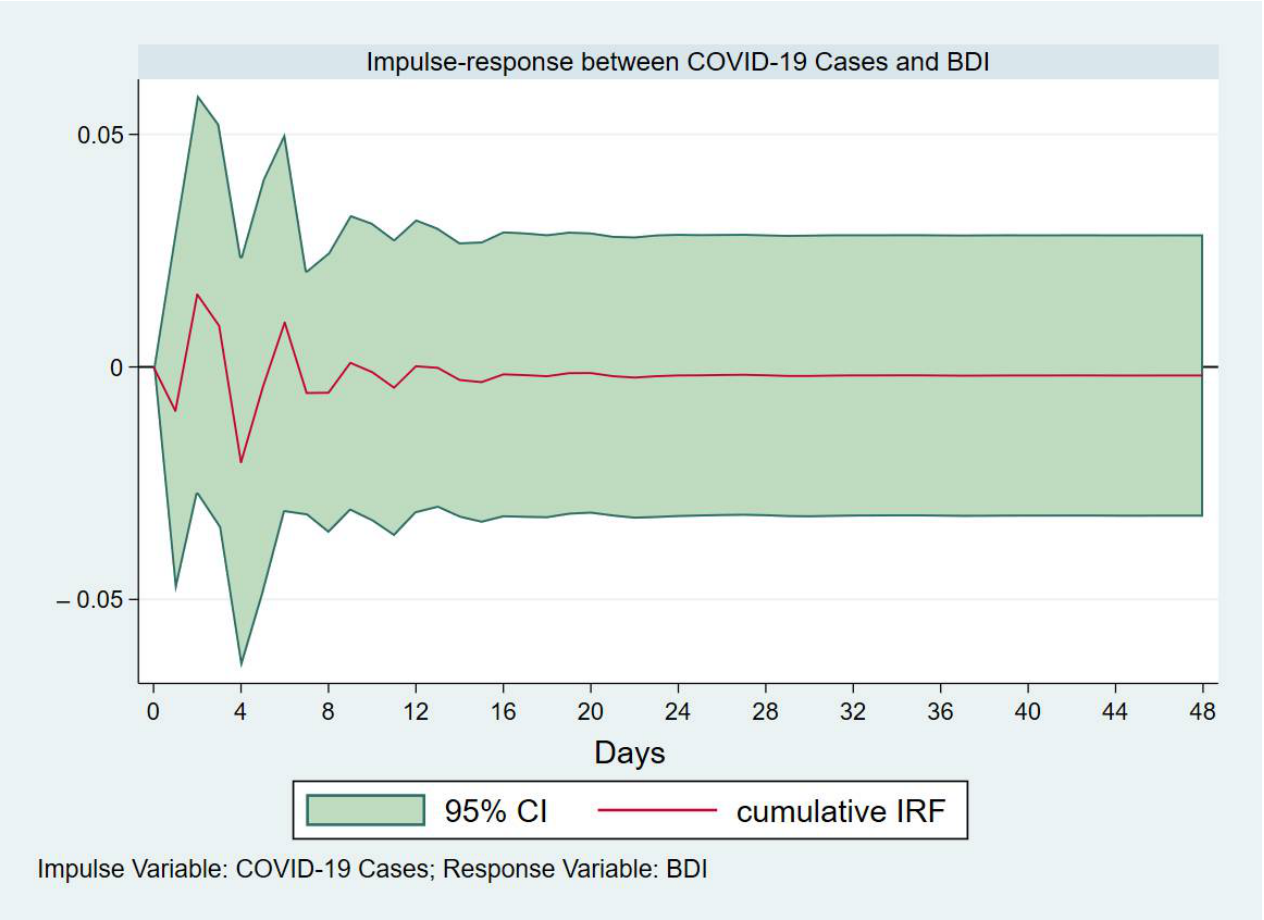
Figure 6. Cumulative impulse response of BDI to COVID-19 cases. Note: The red line represents the estimates, while the green bands represent lower and upper bounds to the 95% confidence intervals.